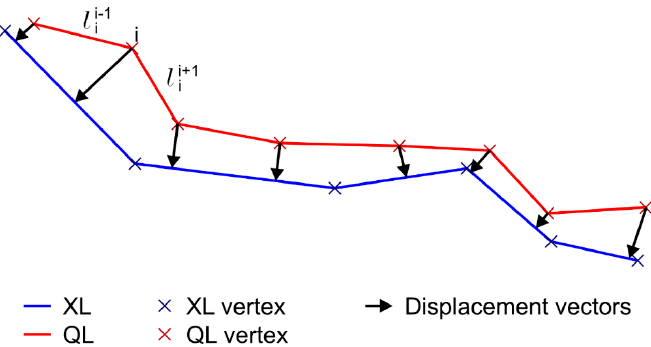
Figure 1. Example of Vertex Influence Method (VIM) [18].